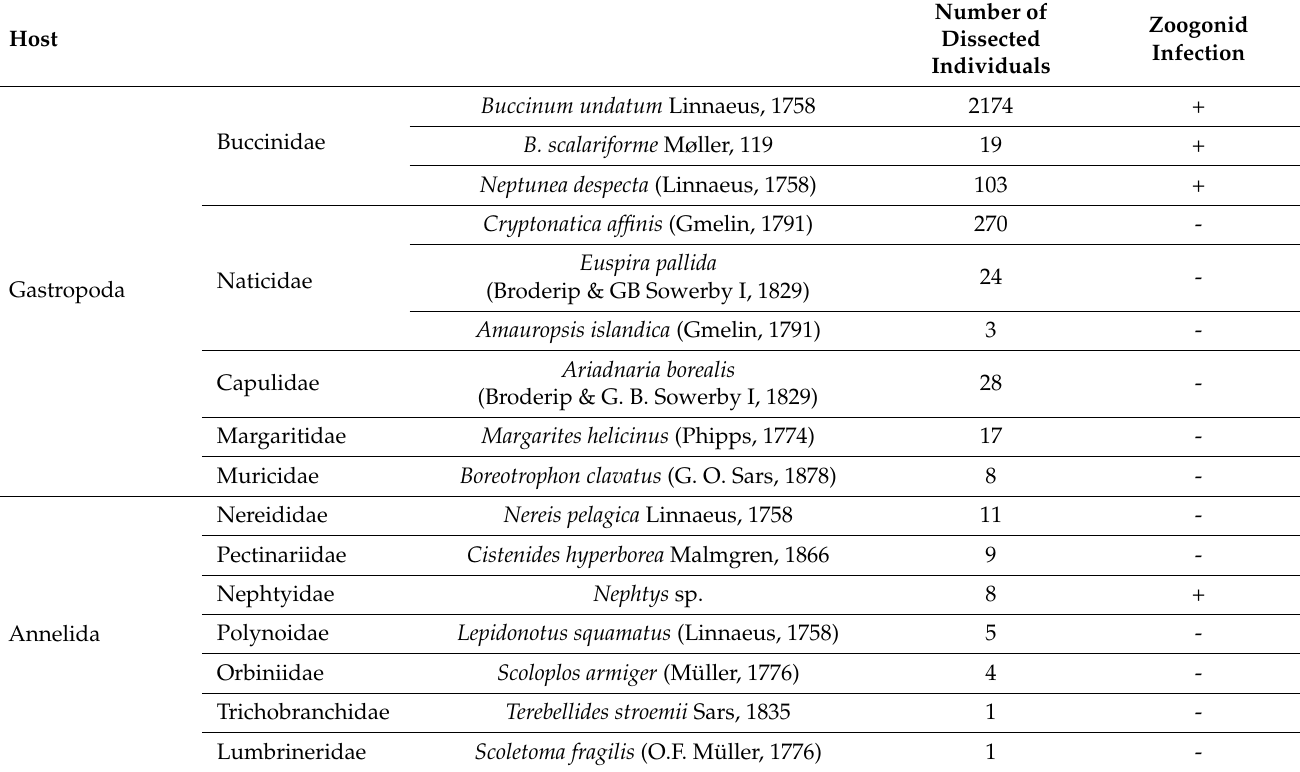
Table 1. List of the dissected White Sea benthic invertebrates and their infection with zoogonid life cycle